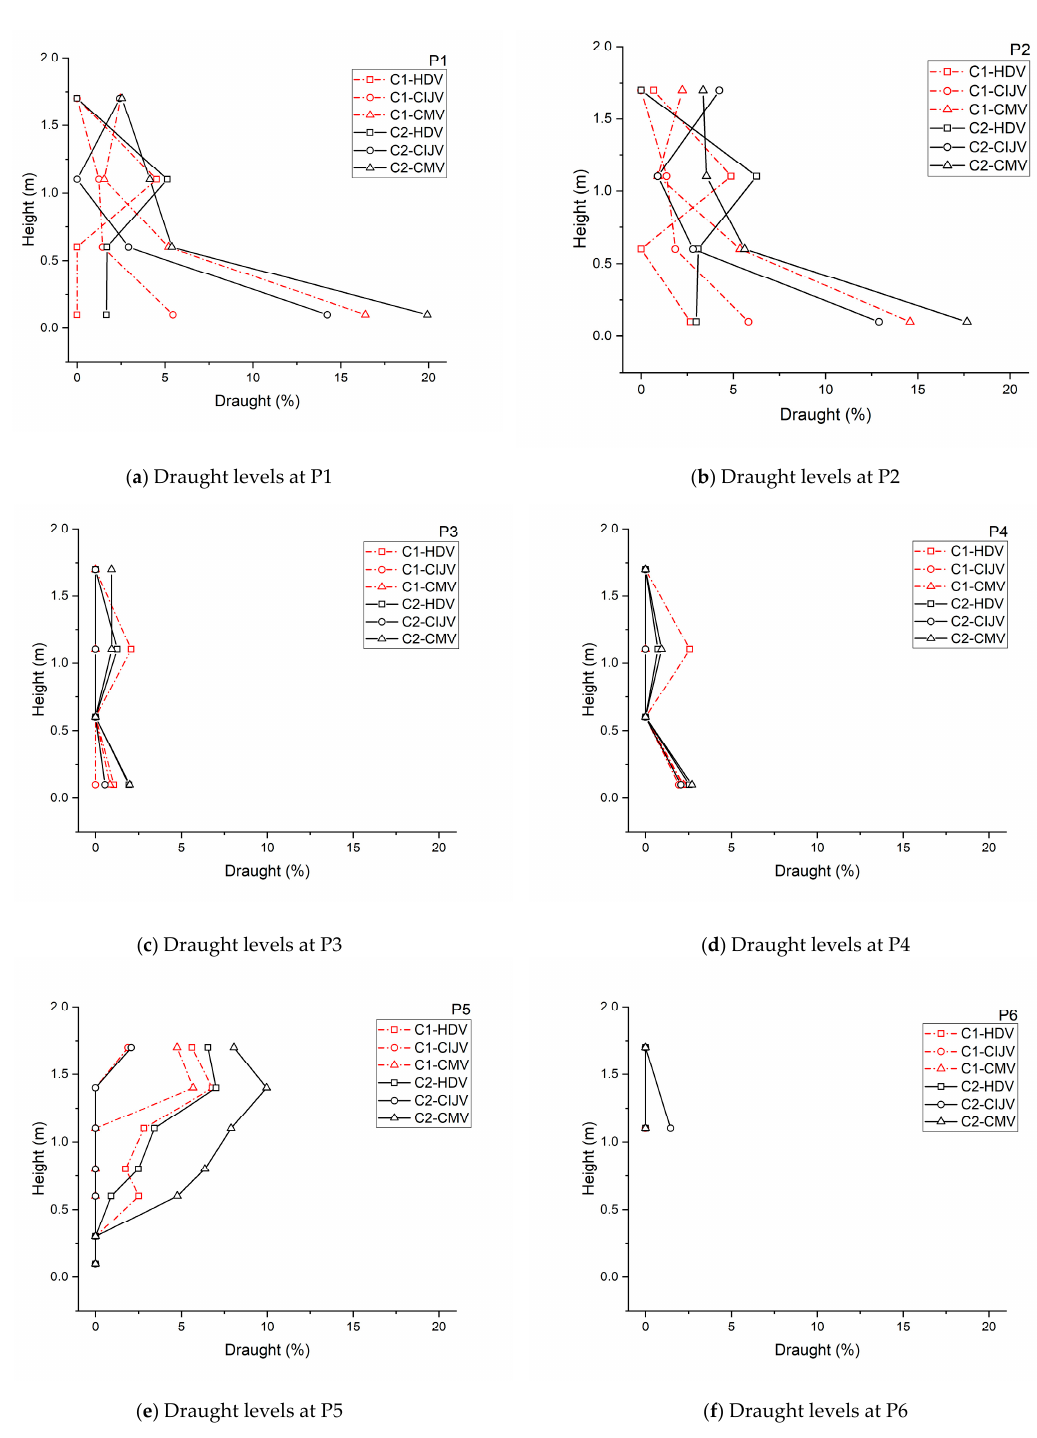
Figure 4. Velocity profiles at position P1 ( a ), P2 ( b ), P3 ( c ), P4 (d), P5 ( e ) and P6 ( f ) for all cases.